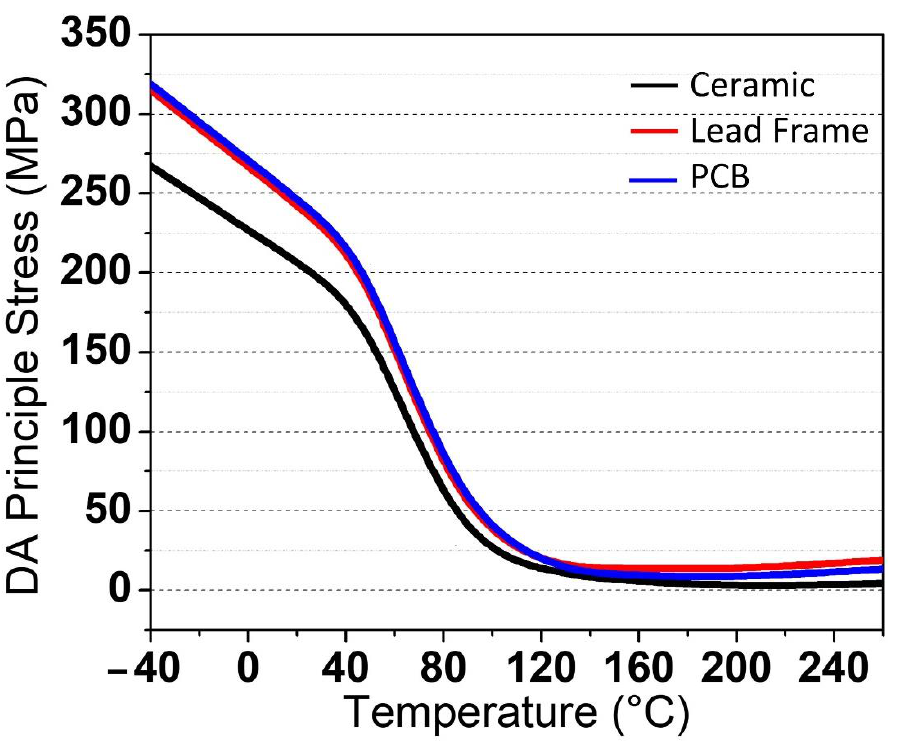
Figure 9. Die-attached (DA) stress values versus temperatures ranging from − 40 °C to 260 °C during the mechanical stress simulation.